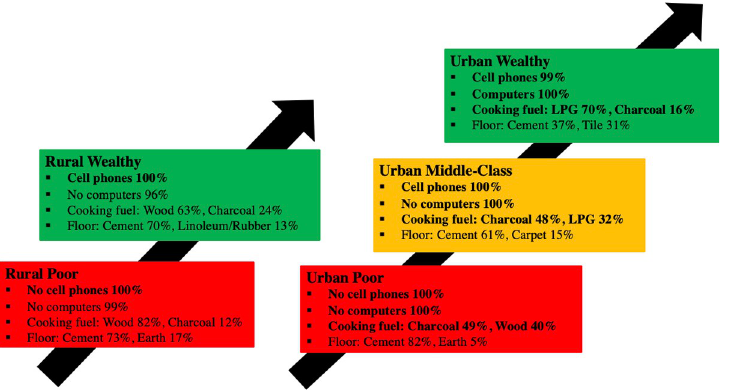
Fig 9. Simplified ordinal EconomicClusters model for